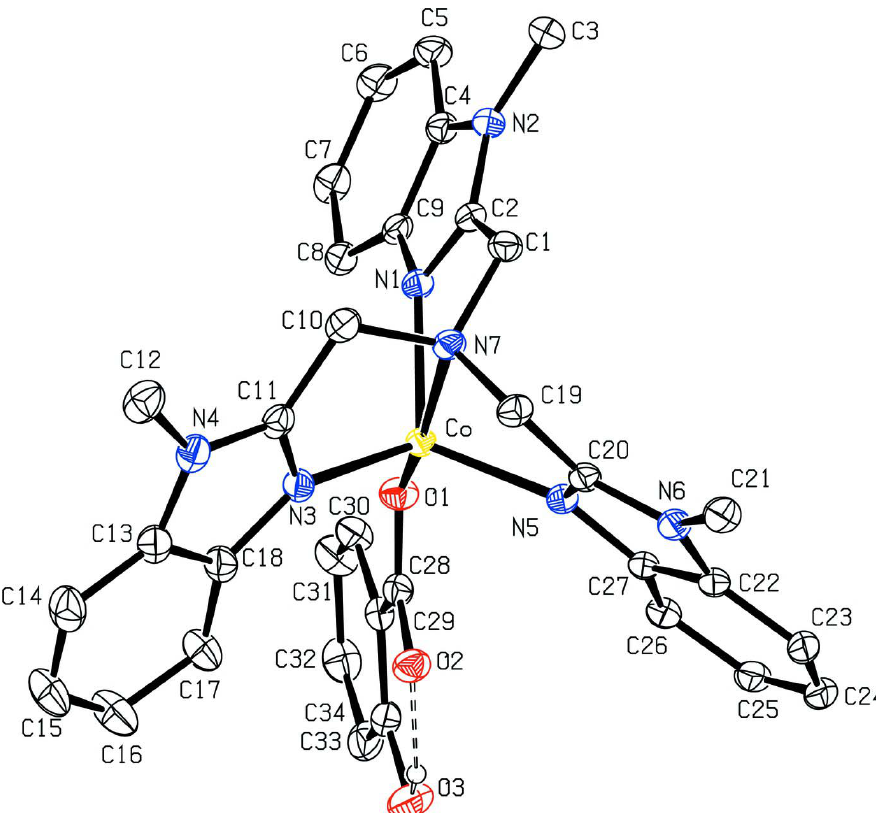
Figure 1 The cation of of the title compound with displacement ellipsoids shown at the 30% probability level. Hydrogen atoms bonded to C atoms are not shown and the dashed line indicates a hydrogen